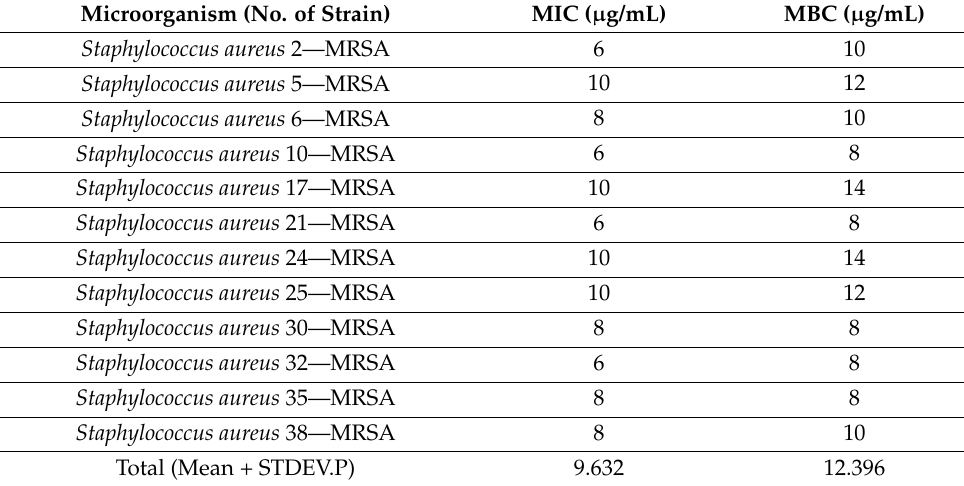
Table 3. Staphylococcus aureus MRSA strains are susceptible to EERP (MIC and MBC and Mean + STDEV.P values in µ g/mL).